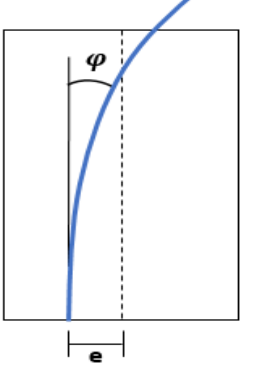
Figure 5. Localization data for the AGV from image.